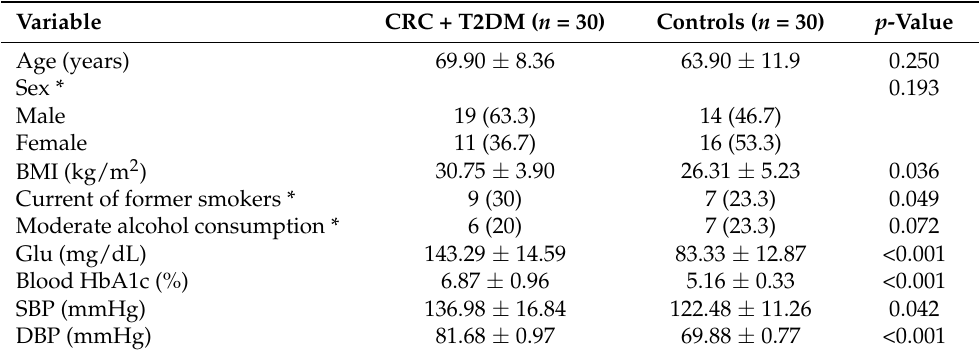
Table 2. Clinical and biochemical characteristics of subjects with CRC + T2DM and